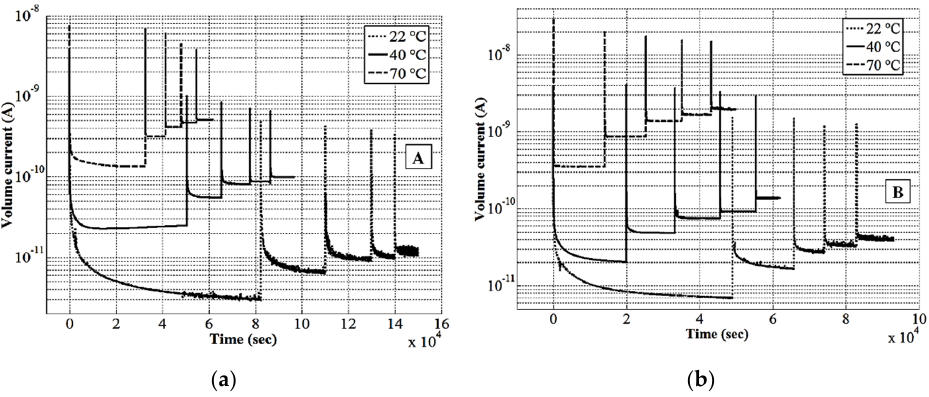
Figure 2. Recorded volume currents through samples of material A ( a ) and alumina try-hydrate (ATH) doped material B ( b ) at different temperatures. Recall that the test voltage is applied in increasing steps (from left to right on the time axis).